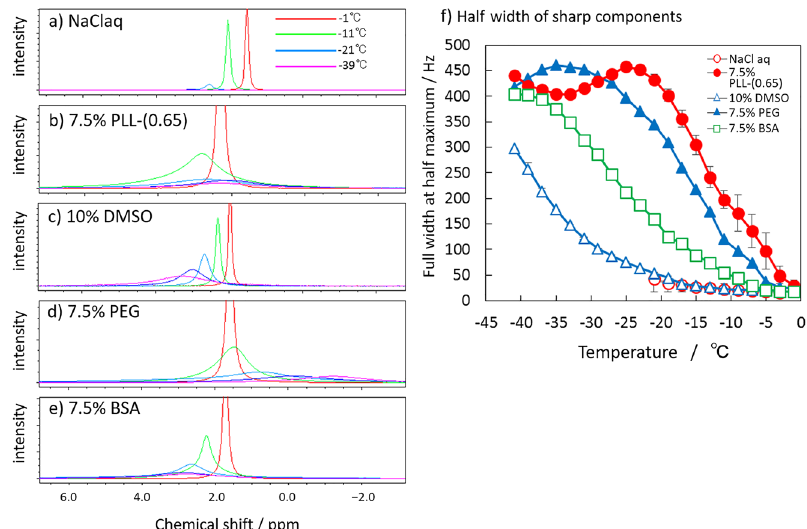
Fig. 3 Na-ion behavior of the CPAs at various temperatures. a – e Solid-state 23 Na NMR spectra of a the saline b 7.5% PLL-(0.65), c 10% DMSO, d 7.5% PEG, and e 7.5% BSA solutions. f Full-widths-at-half-maximum for the sharp components as functions of temperature. Error bars represent standard deviation. Table 1 Relationship between the water and Na-ion behavior from the viewpoint of peak